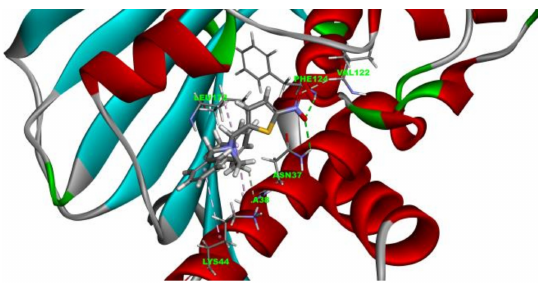
Figure 4. Molecular docking analysis of the 4a -yeast Hsp90 complex. Predicted binding mode of 4a and Hsp90. Hydrogen bonds are indicated by green dashed lines. The Pi-alkyl interaction is shown by a pink dashed